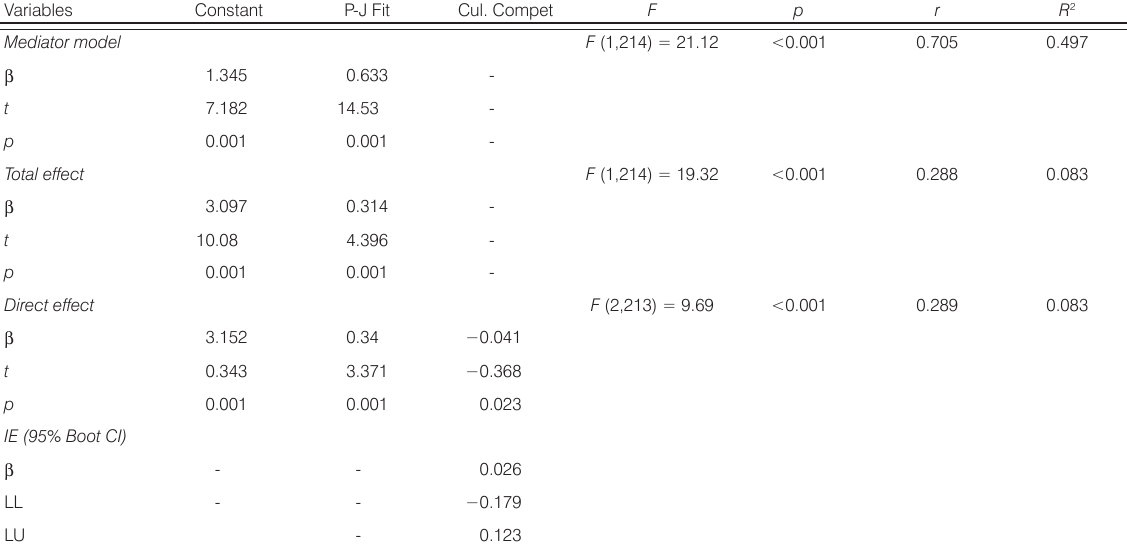
Table 2. Simple mediation model of person-environment fit, cultural competence, and work-life